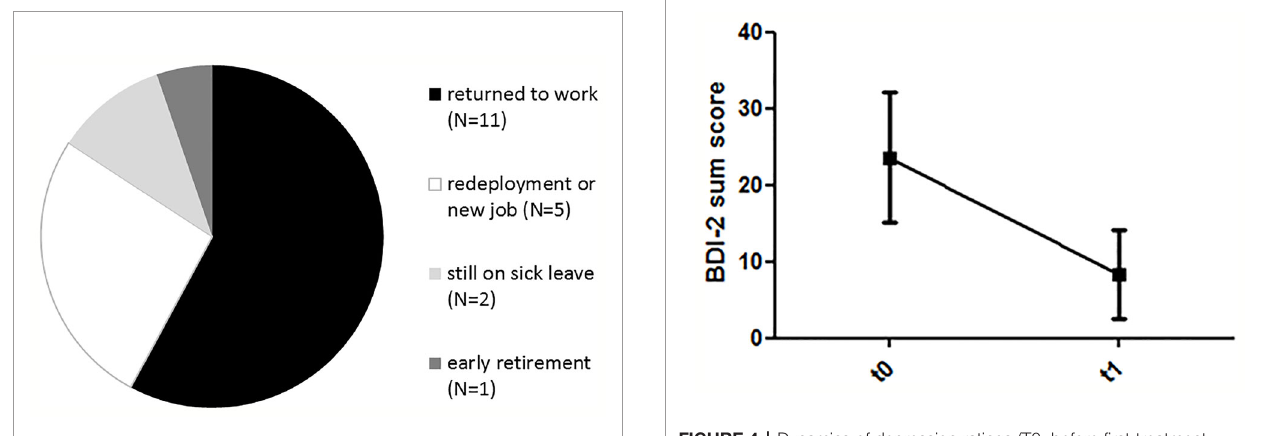
FIGURE 3 | Treatment outcome concerning return to work.